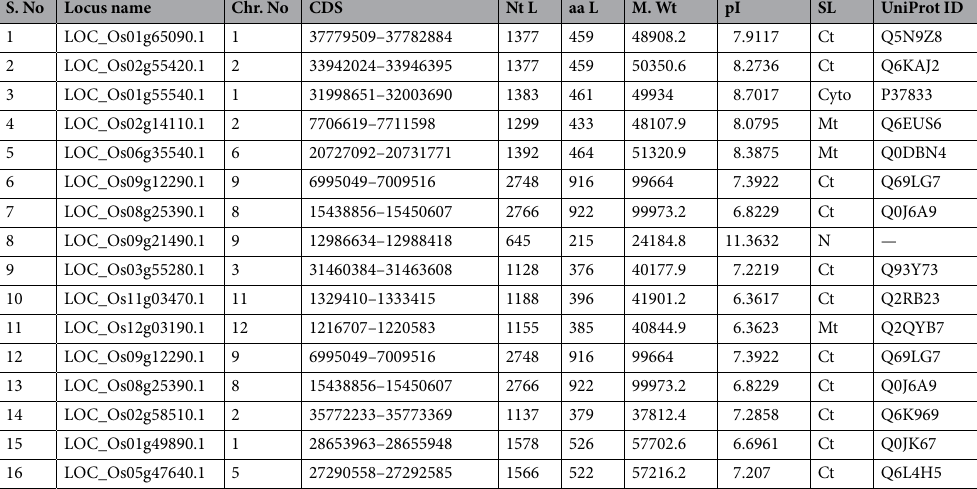
Table 2. Gene attributes of threonine. Chr, Chromosome; CDS, Coding sequence; Nt L, Nucleotide length; aa L, amino acid length; M.Wt, Molecular weight; pI, Isoelectric point; SL, subcellular localization; Cyto, Cytosol; N, Nucleus; Mt, Mitochondria; Ct,